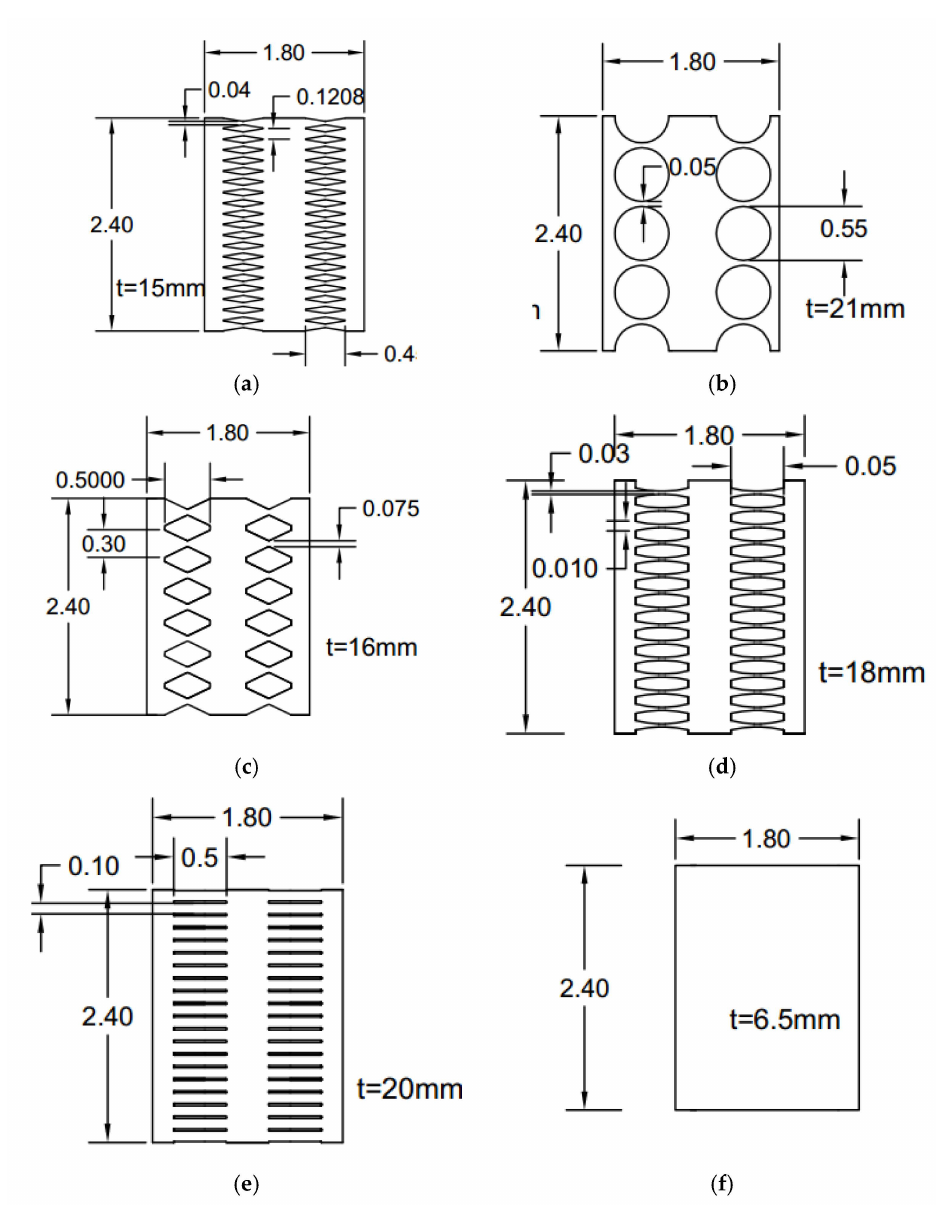
Figure 11. The multiple rows of links ( a ) FBF ( b ) Circle ( c ) SBF ( d ) Oval ( e ) Solid ( f ) Straight.